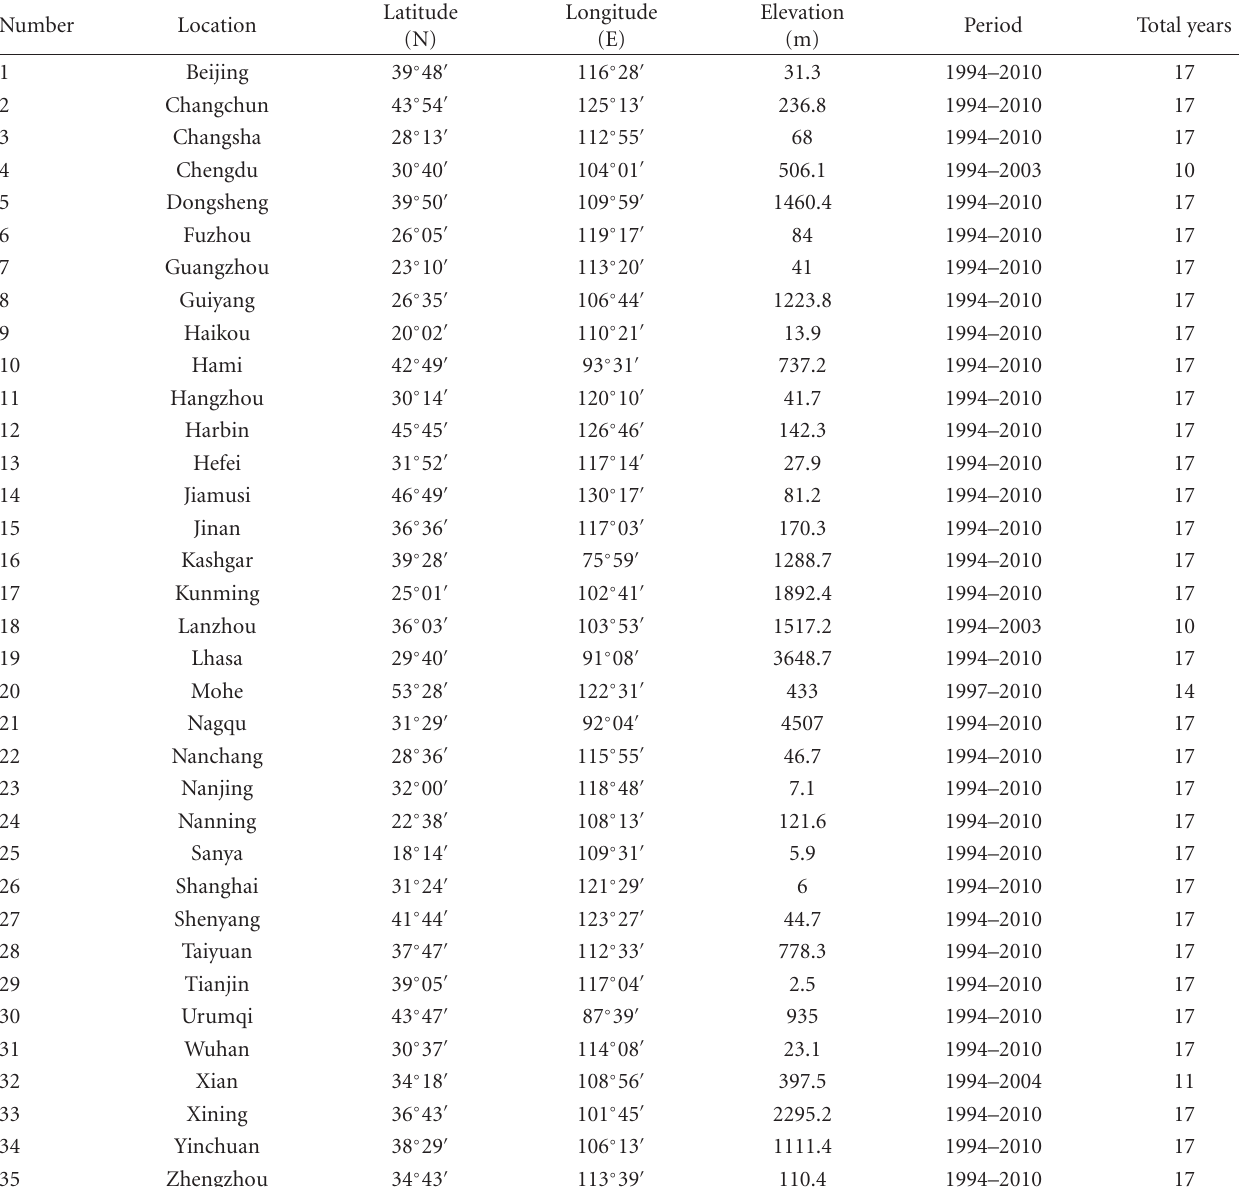
Table 1: Geographical locations and data period of the meteorological stations used for this